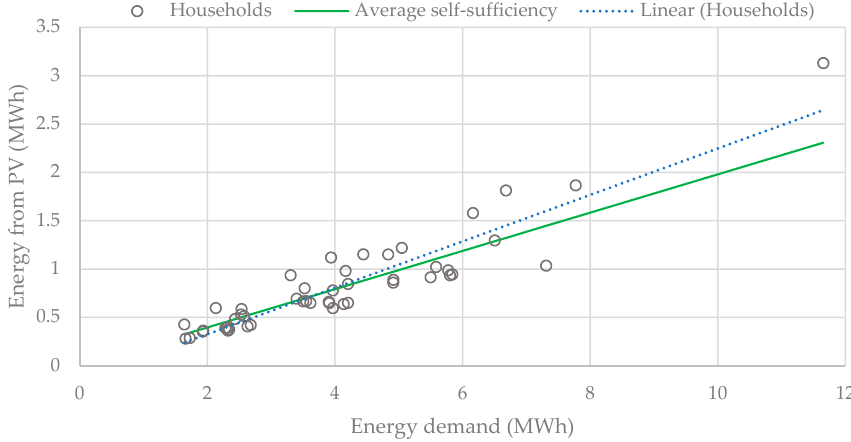
Figure 9. Annual cumulative energy demand and annual cumulative energy used from the PV system for every household in the local grid.